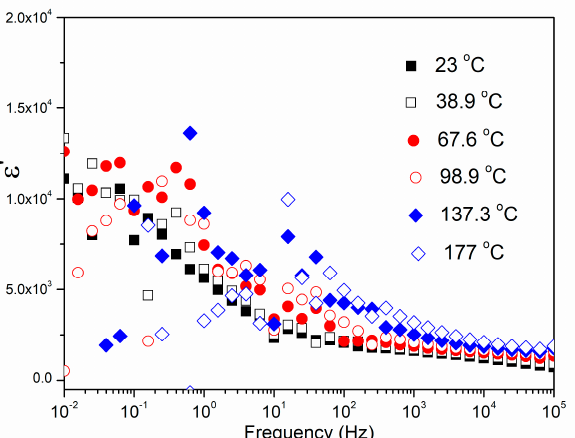
Figure 8. The Arrhenius plot of conductivity ln( σ ) versus 1000/T of CCTO ceramic. Figure 9 represents the influence of both the temperature and the frequency on the dielectric properties of the CCTO ceramic. The measurements were done in the frequency interval from 100 kHz to 0.01 Hz and in the temperature range between 177 and 23 °C.